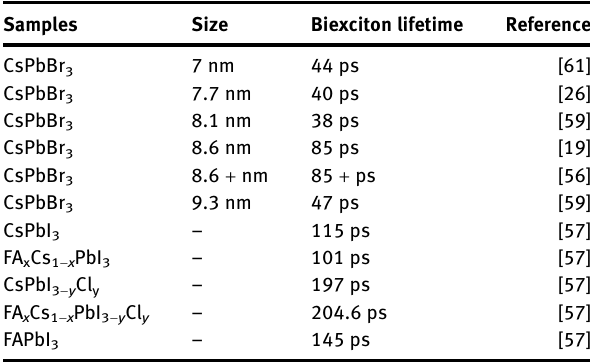
Table  : Biexciton lifetime of different